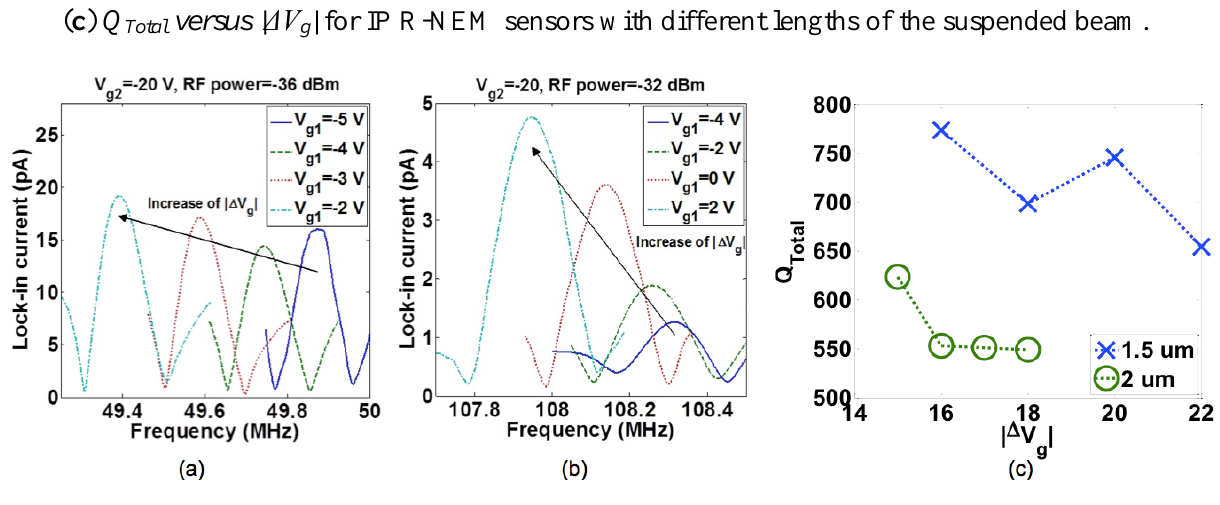
Figure 18. The effect of various radio frequency (RF) power on the frequency characteristics of the: ( left ) 2 μm-length and ( right ) 1.5 μm-length in-plane resonant nano-electro-mechanical (IP R-NEM)